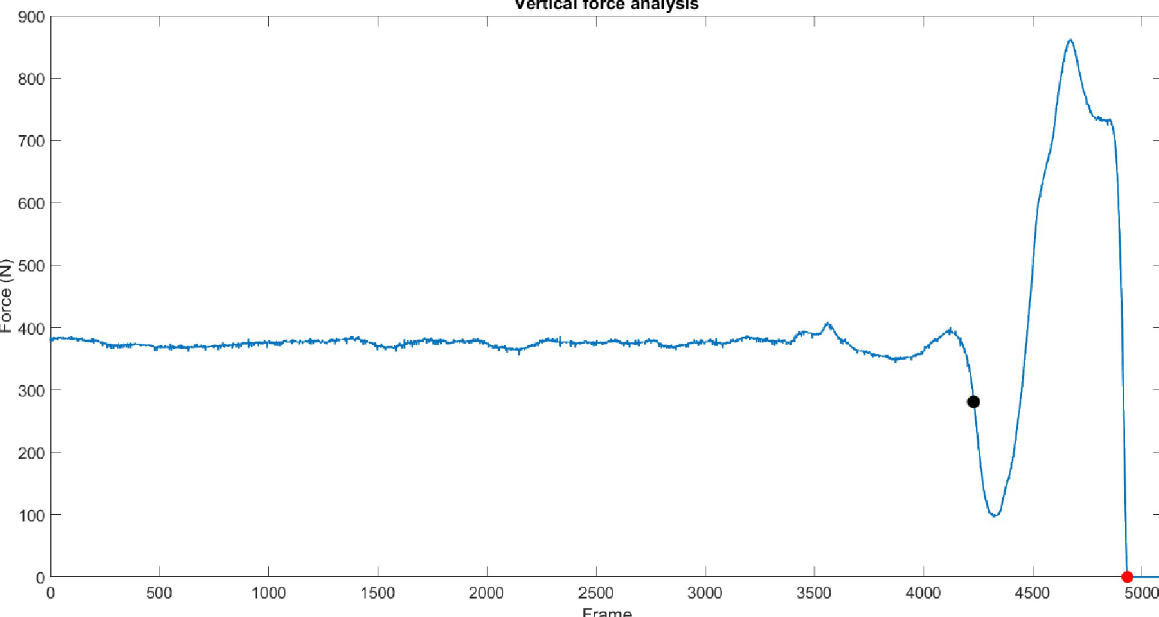
Fig 2. Analysis of the vertical force. Black square indicates the end of the unweighted phase whereas the red one the start of the time flight. As an example, the figure only reports the analysis of one of the two force platforms.